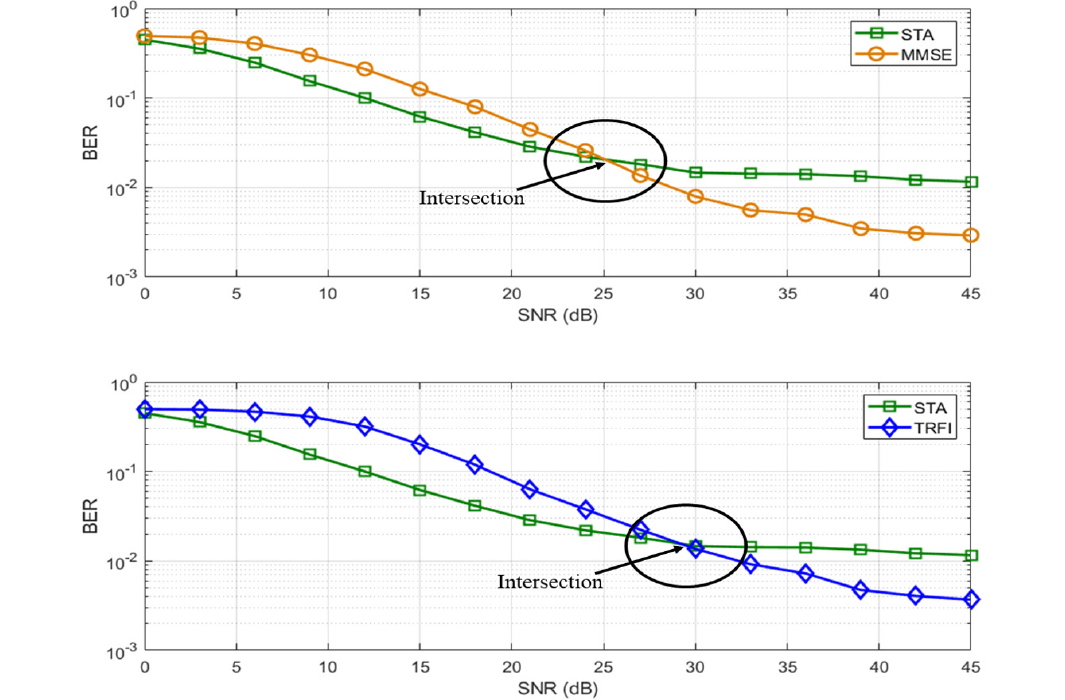
Figure 3. BER performance of QPSK 1/2 in V2I Urban